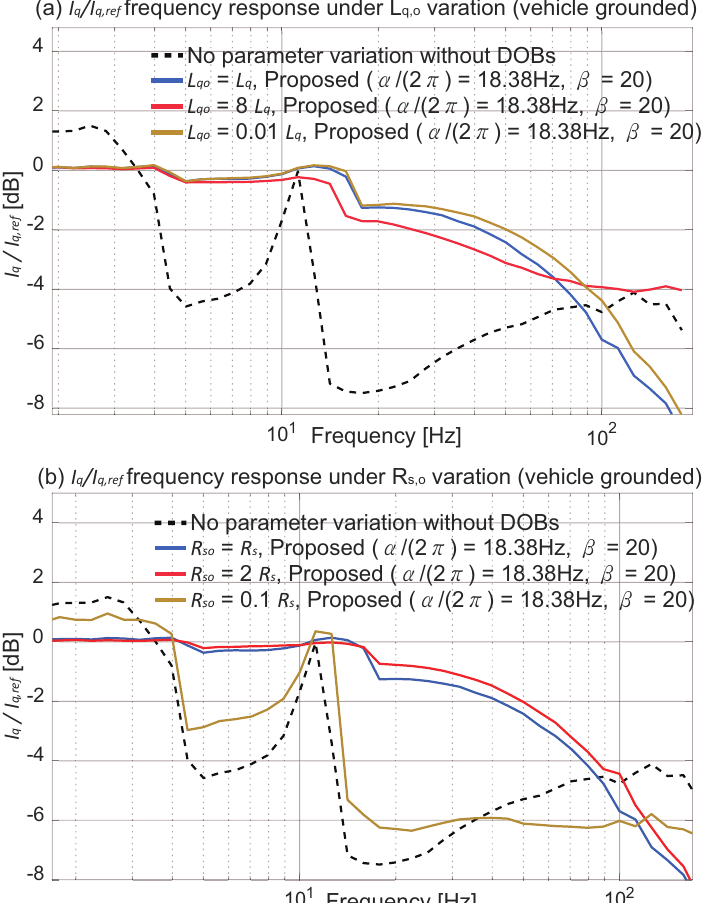
Figure 14. Experiment 2: q -axis current responses when there is ( a ) inductance parameter variation and ( b ) resistance parameter